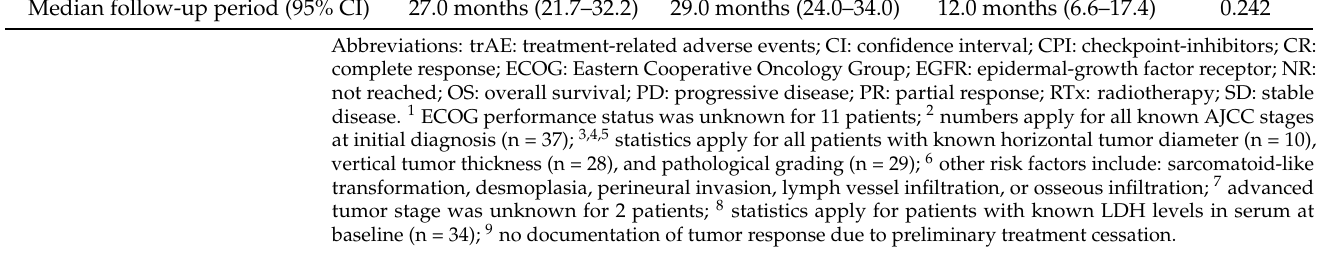
Table 2. Baseline patient characteristics and treatment outcomes for patients diagnosed with